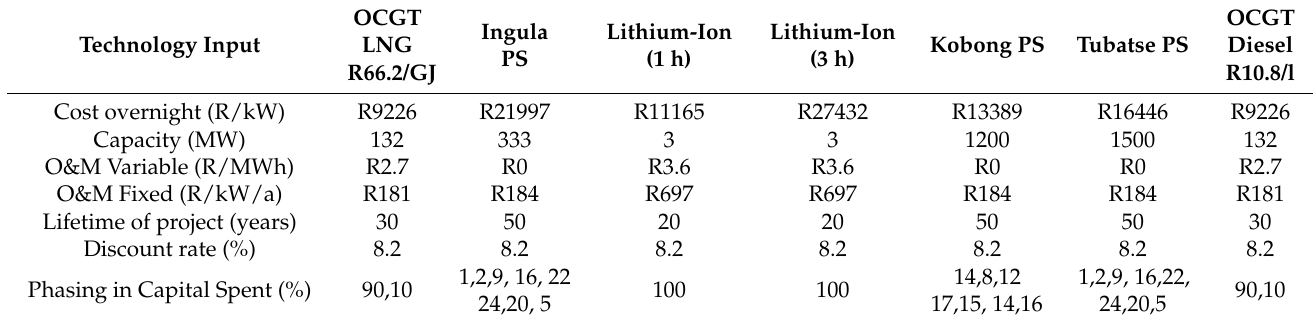
Table 2. Input parameters from IRP 2019 with Kobong and Tubatse